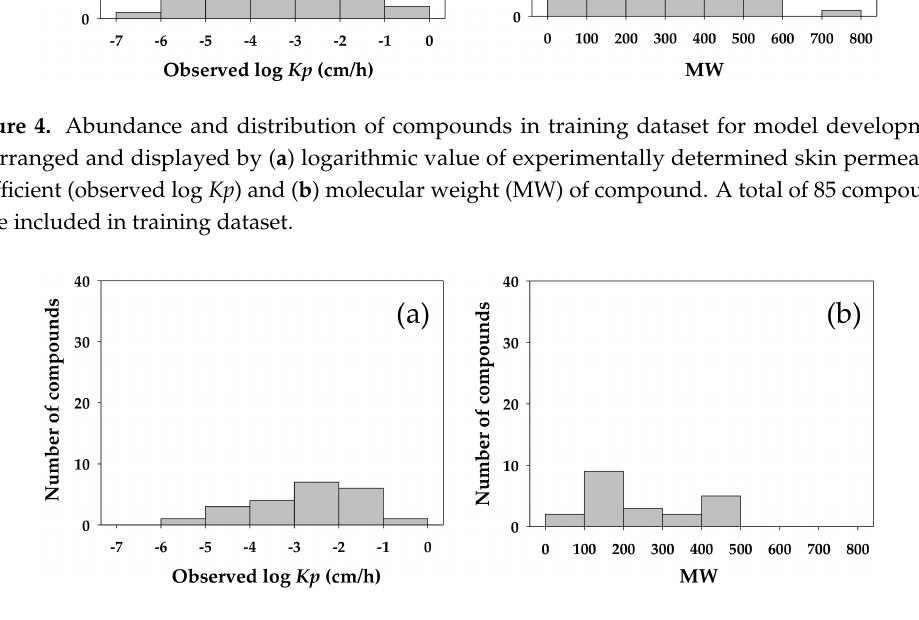
Figure 5. Abundance and distribution of compounds in validation dataset for model development as arranged and displayed by ( a ) logarithmic value of experimentally determined skin permeation coefficient (observed log Kp ) and ( b ) molecular weight (MW) of compound. A total of 21 compounds were included in validation dataset.